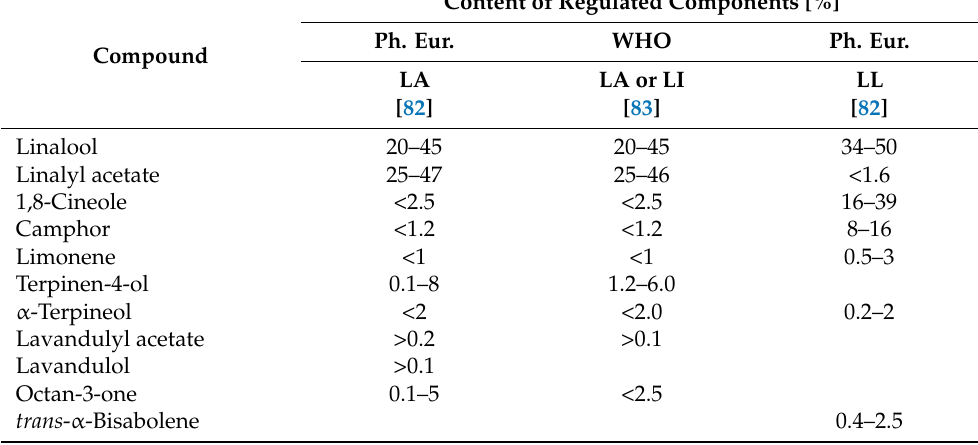
Table 8. WHO and European pharmacopeia (Ph. Eur.) standards for a chromatographic profile of Lavandula sp. essential